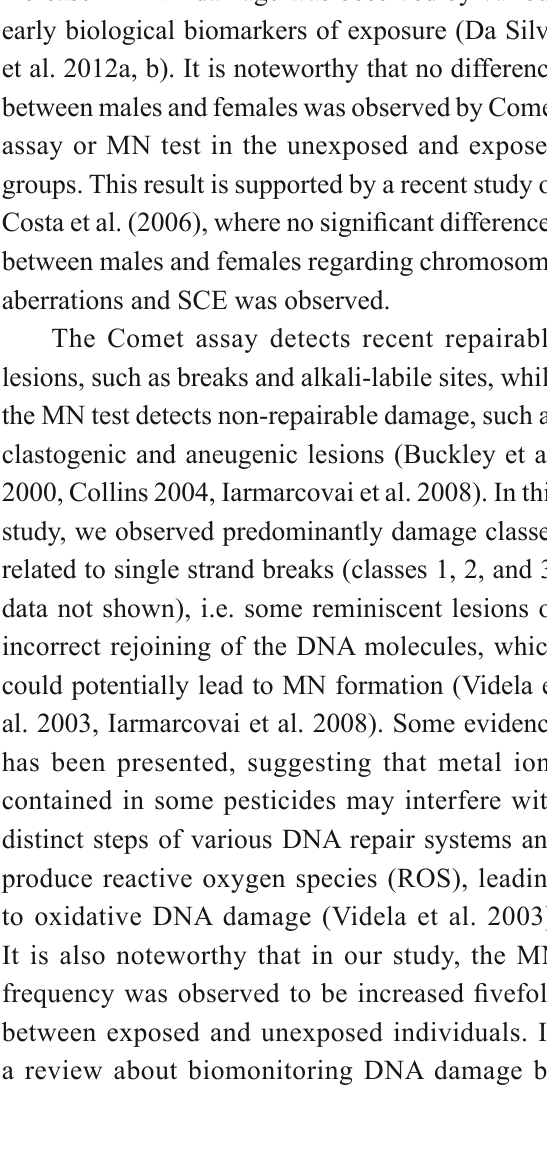
* P<0.05 in relation to unexposed group. Mann-Whitney U